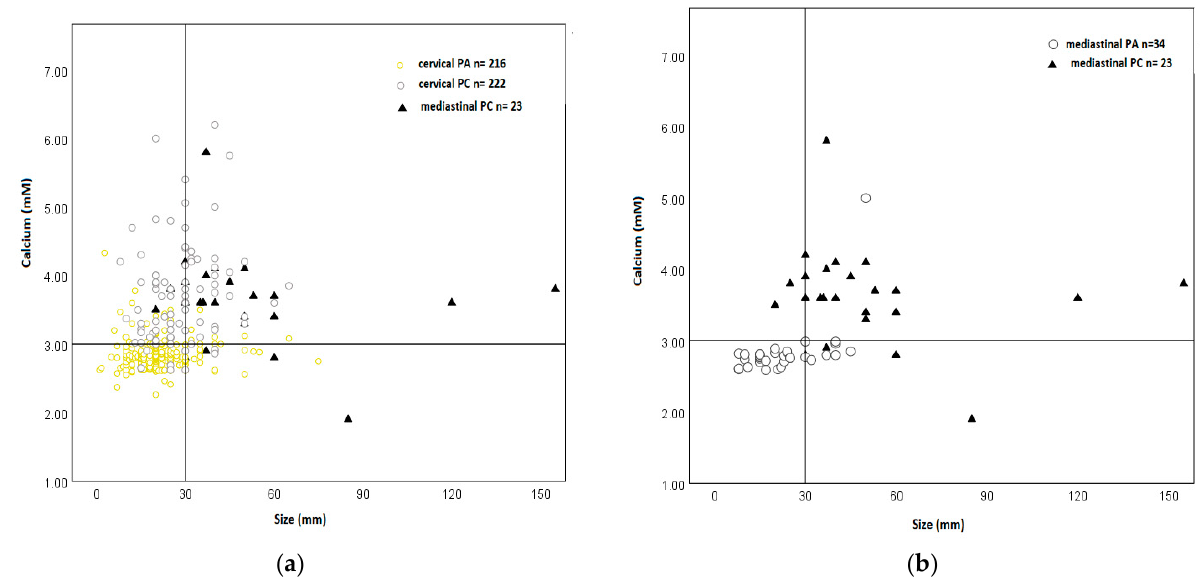
Figure 2. Scatter plot of calcium levels versus tumour size of benign and malignant parathyroid neoplasms in cervical ( a ) and mediastinal ( b ) location. Legend to Figure 1: The criterion for a lesion to be suspicious at a size > 3.0 cm or hypercalcaemia > 3.0 mM is referred to as the “3 + 3 rule” obtained from Schulte and Talat [12] . ( a ) ( left ) parathyroid adenomas and cervical PC have been obtained from Schulte and Talat [12] . ( b ) ( right ), the cohort of 23 mediastinal parathyroid cancer patients corresponds to the patients in Supplementary Table S1. The data for 34 mediastinal adenomas are from patients in our own service.